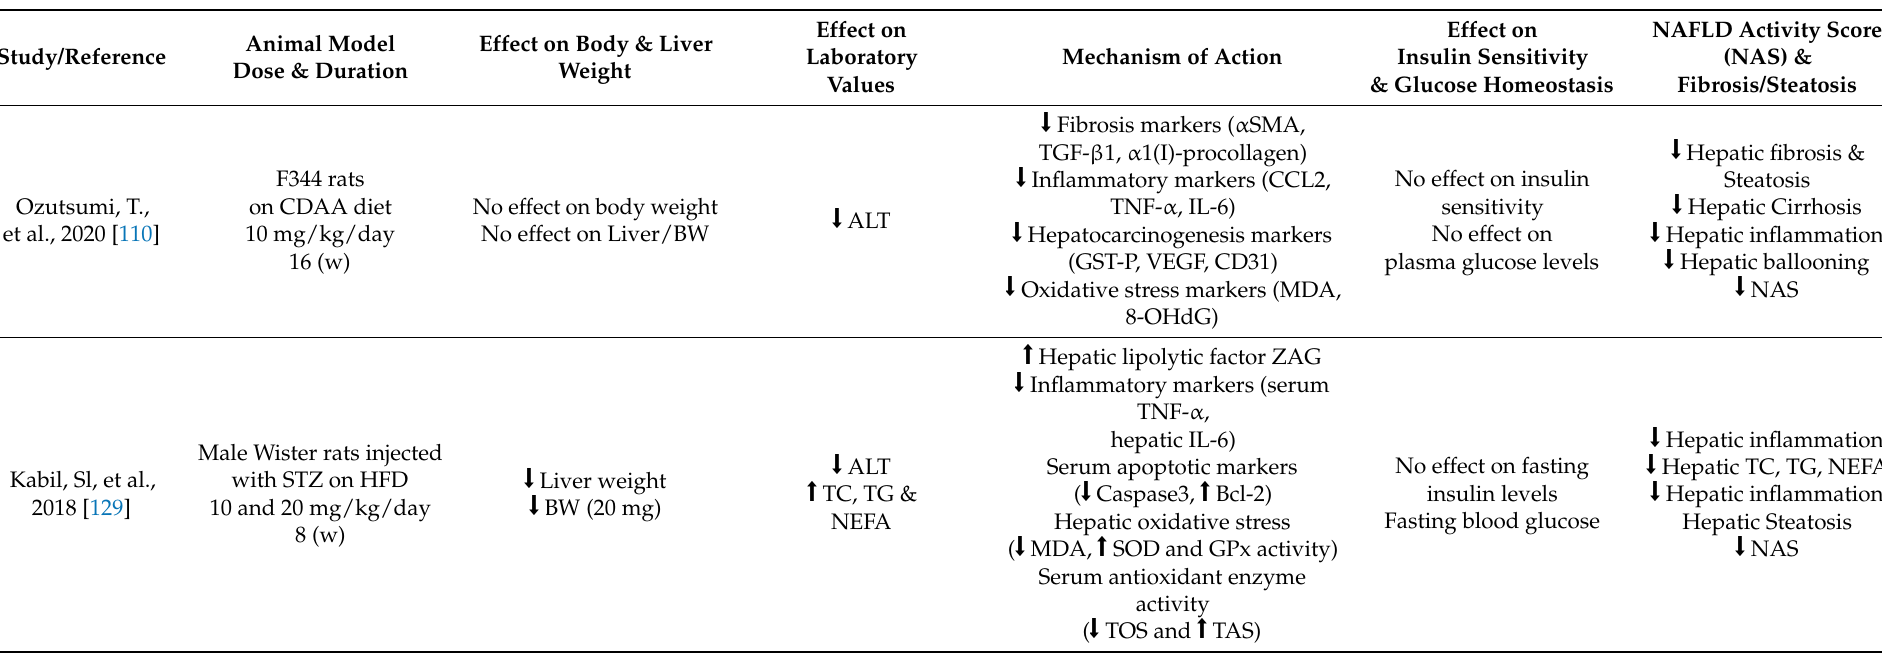
Table 1. Key animal studies regarding the impact of empagliflozin on NAFLD/NASH.